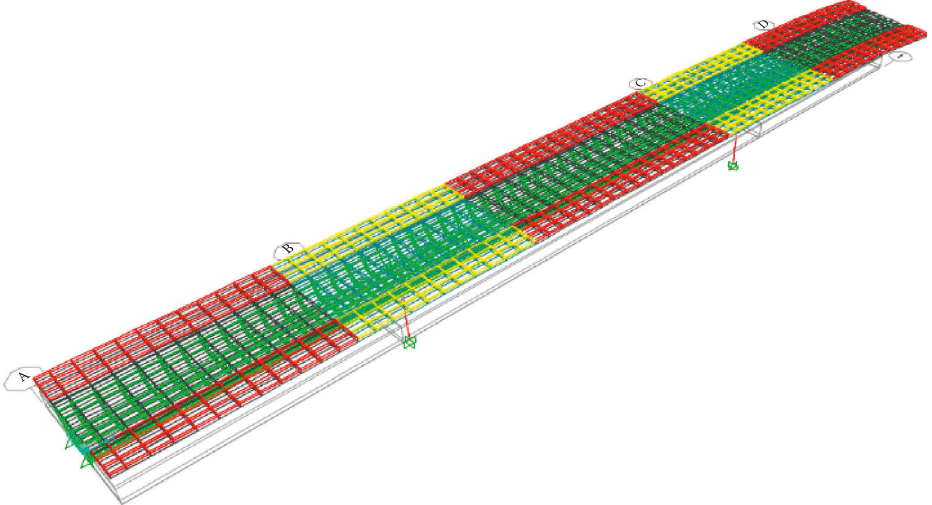
Figure 4: Finite element model of the Magaz bridge. Table 1: Comparison between the experimental and the numerical modes for the initial model. Experimental